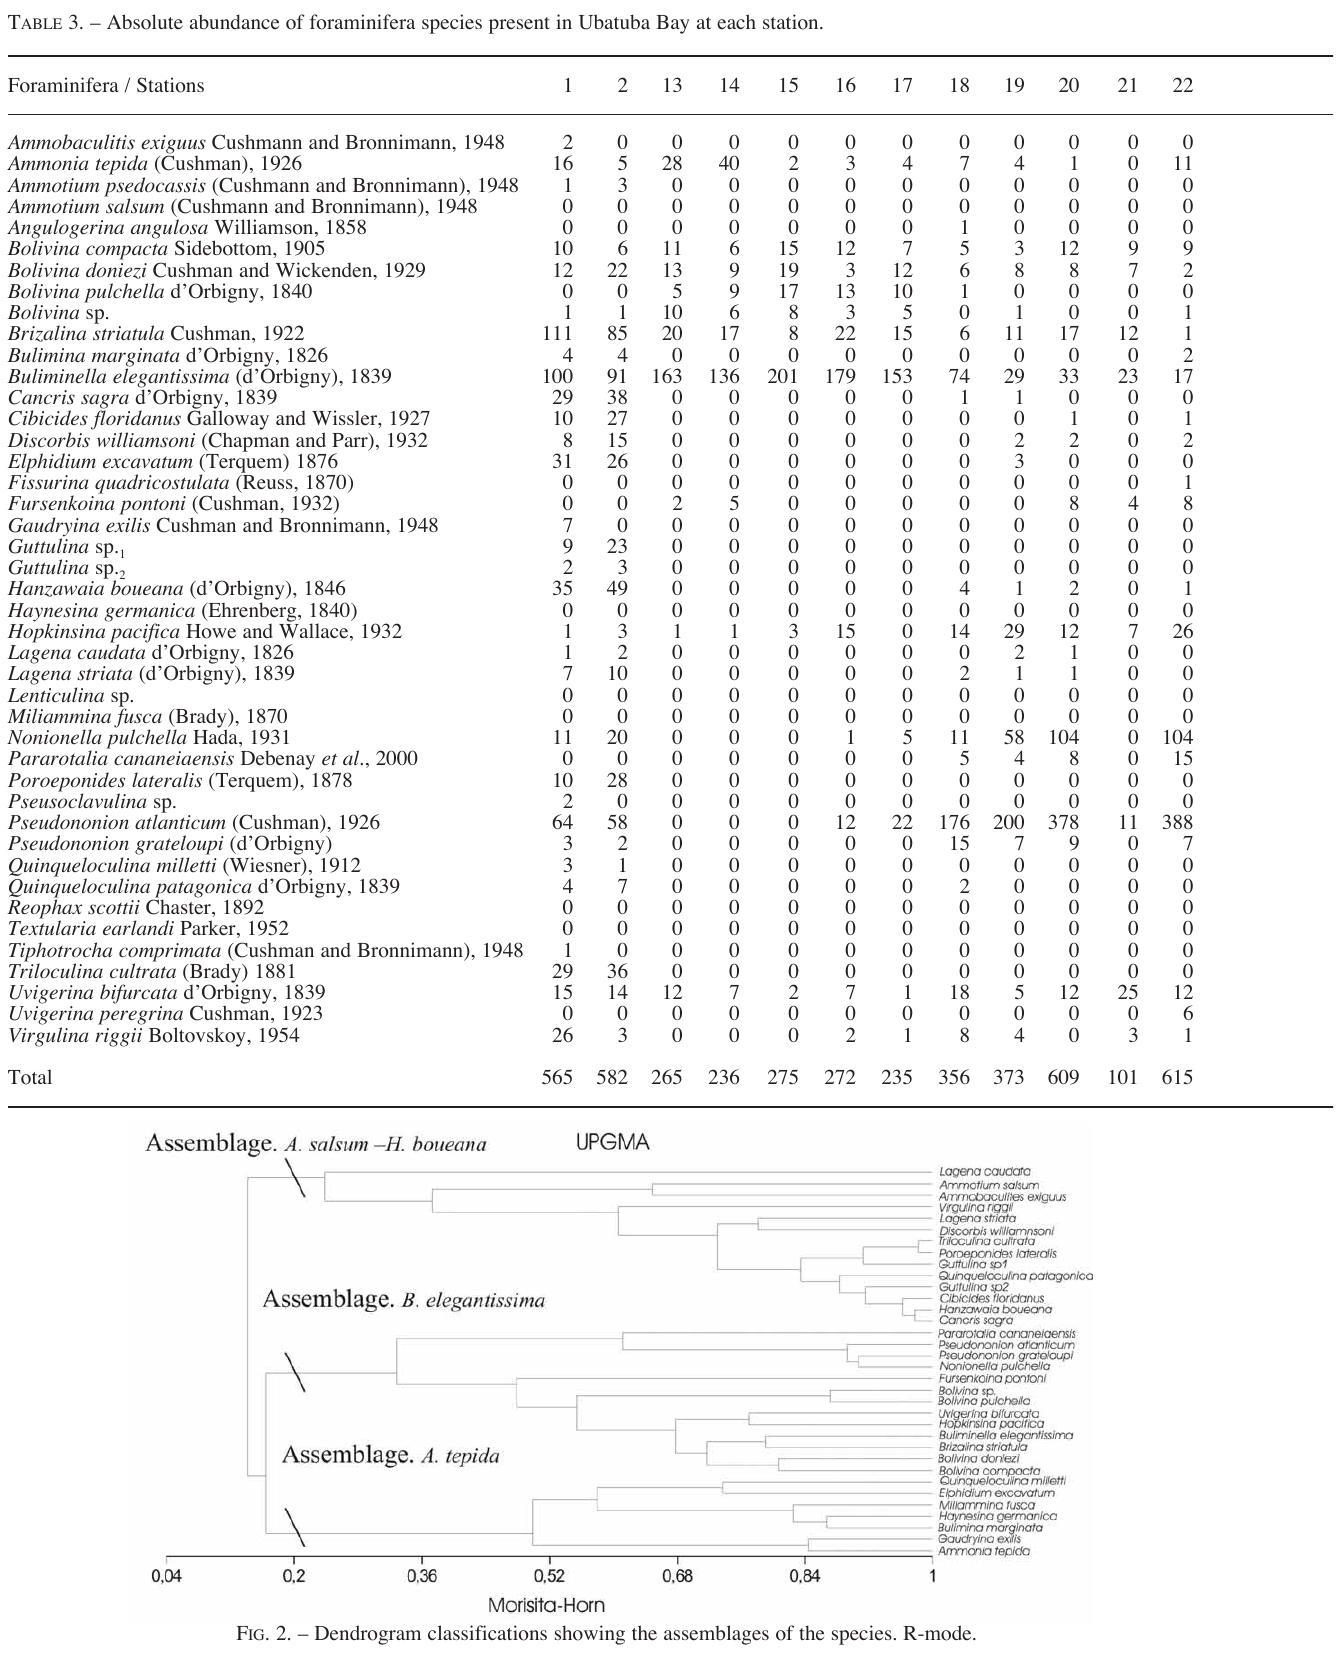
F IG . 2. – Dendrogram classifications showing the assemblages of the species.